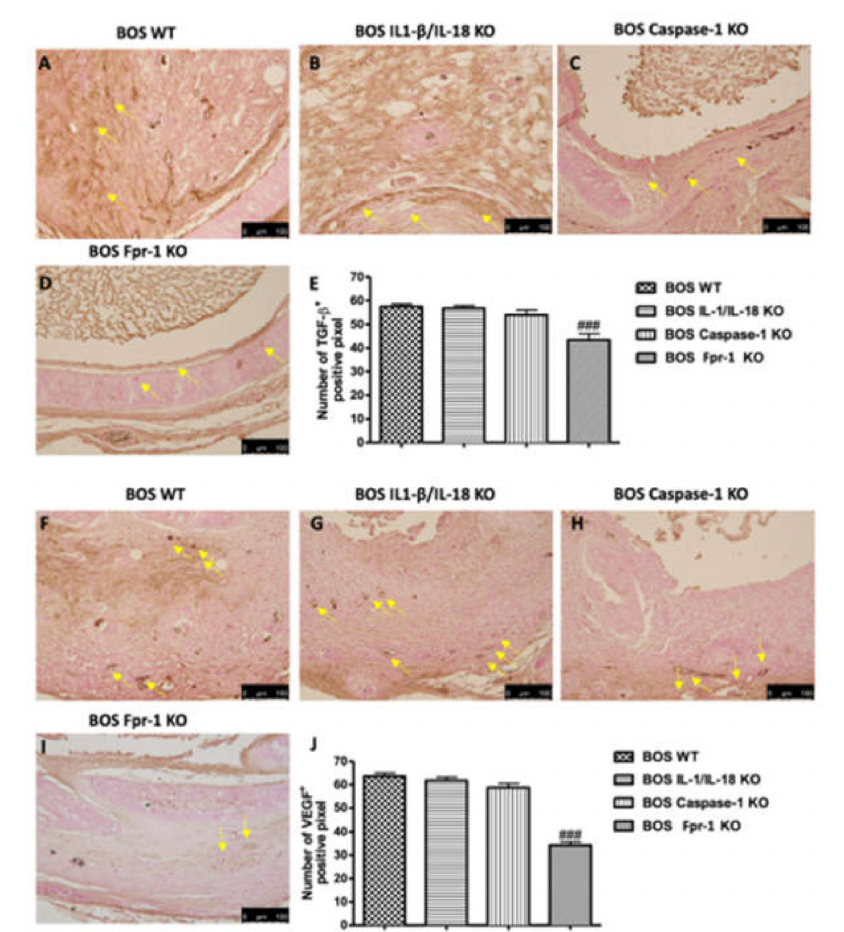
Figure 6. E ff ects of the absence of IL-1 β / IL-18, Casp-1, and Fpr-1 on growth factor expression. Immunohistochemistry evaluation of VEGF expression: WT ( A ), IL-1 β / IL-18 KO ( B ), Casp-1 KO ( C ), Fpr-1 KO ( D ), densitometric analysis ( E ). Immunohistochemistry evaluation of TGF- β expression: WT ( F ), IL-1 β / IL-18 KO ( G ), Casp-1 KO ( H ), Fpr-1 KO ( I ), densitometric analysis ( J ). Yellow arrows point the positive cells. For immunohistochemistry, n = 5 animals from each group were employed. A p -value less than 0.05 was considered significant. ### p < 0.001 versus the WT